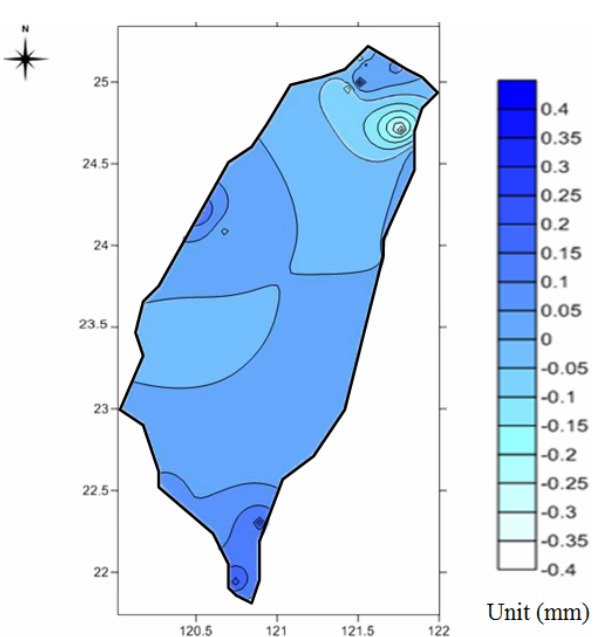
Fig. 6. Residual map of the averages of daily evaporation residuals. 533